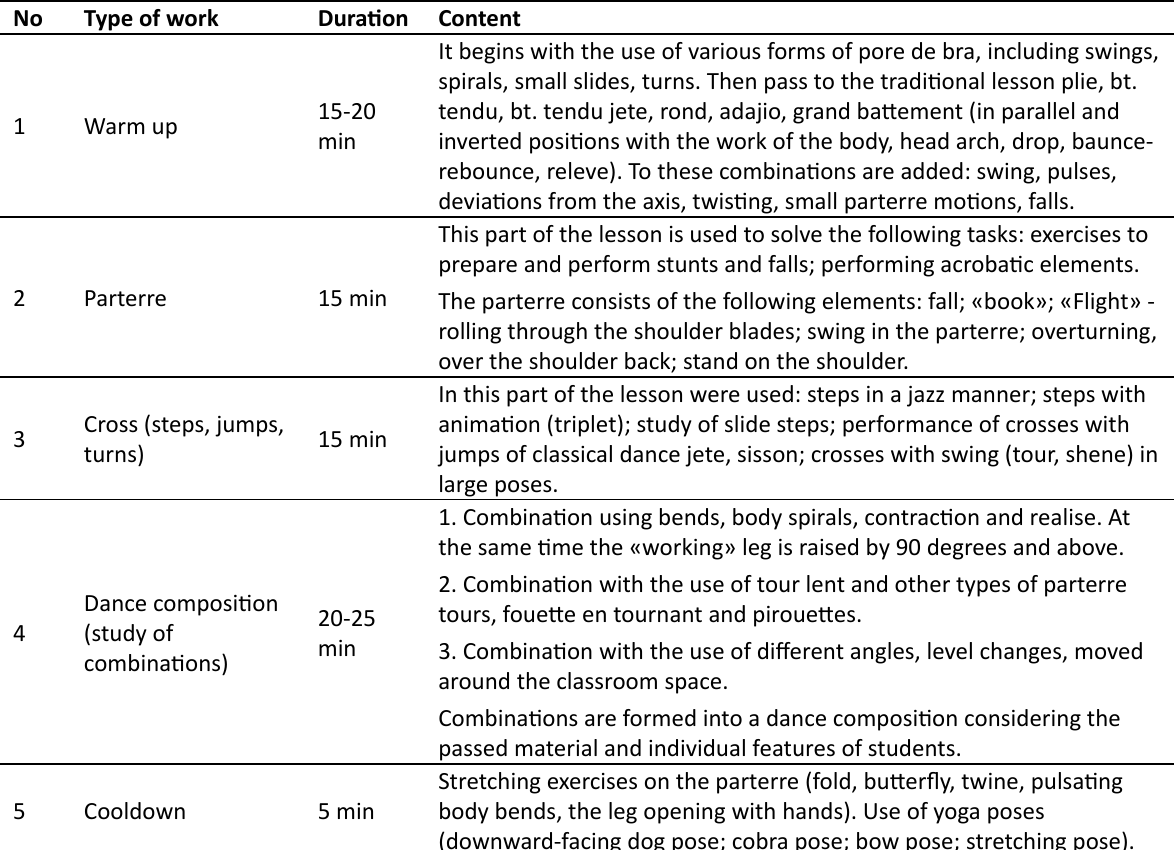
Table 1. The tasks structure of three semesters performance by students